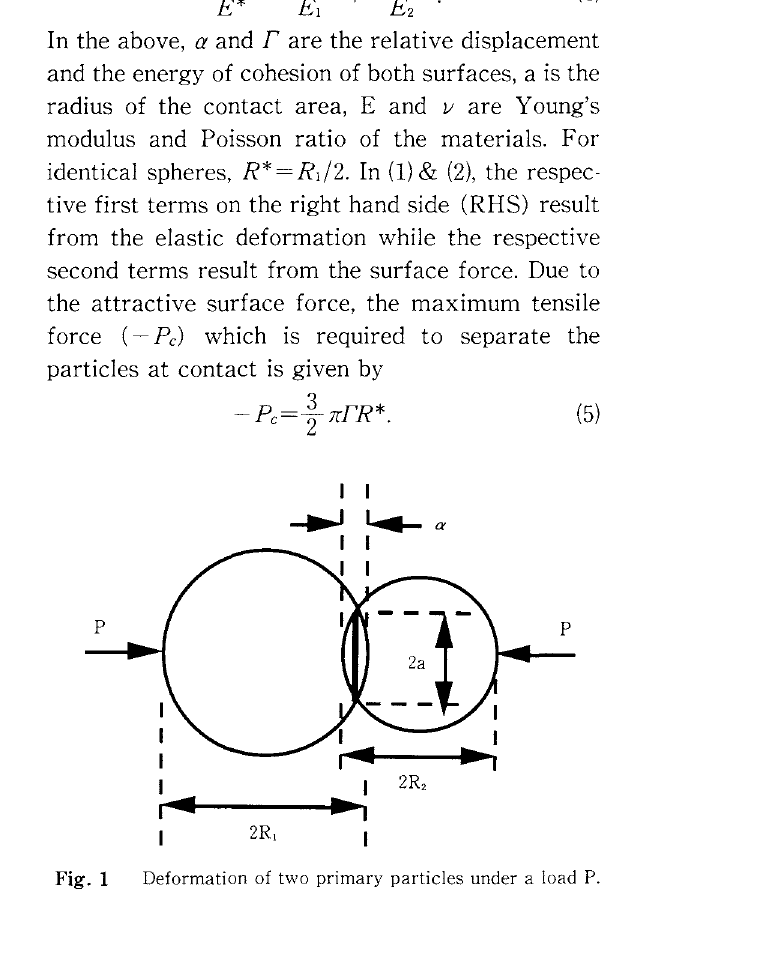
Fig. 1 Deformation of two primary particles under a load